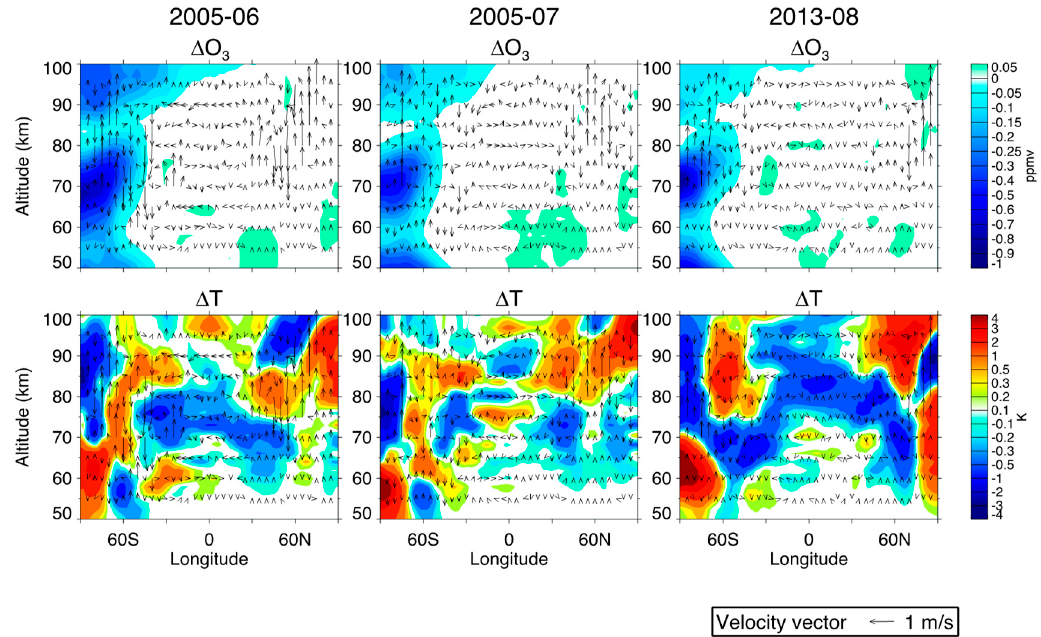
Figure 12. Same as in Figure 11 but in June 2005, July 2005, and August 2013 (for high geomagnetic activity period).